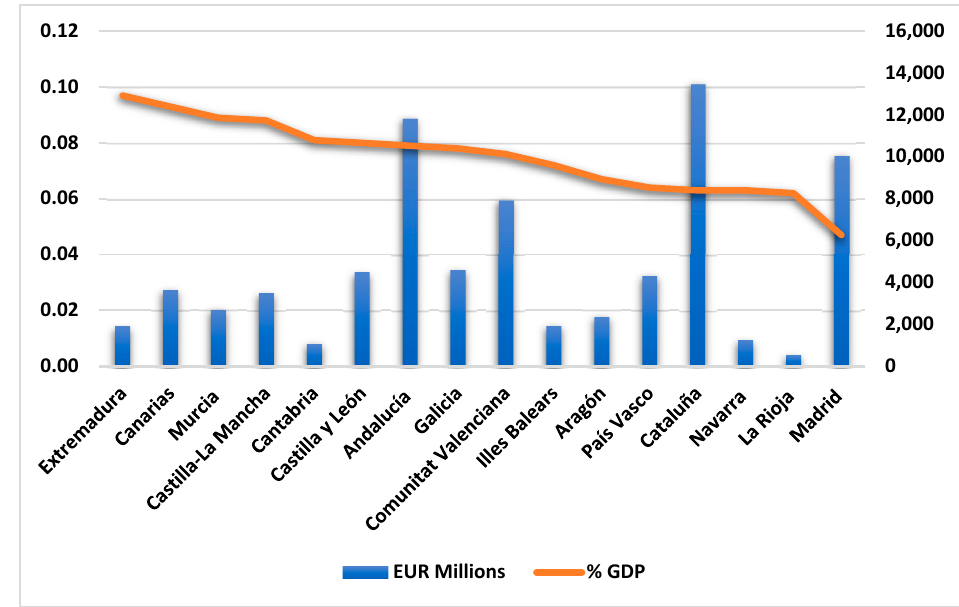
Figure 3. Public healthcare expenditure of the Spanish autonomous communities in 2020. Source: Ministry of